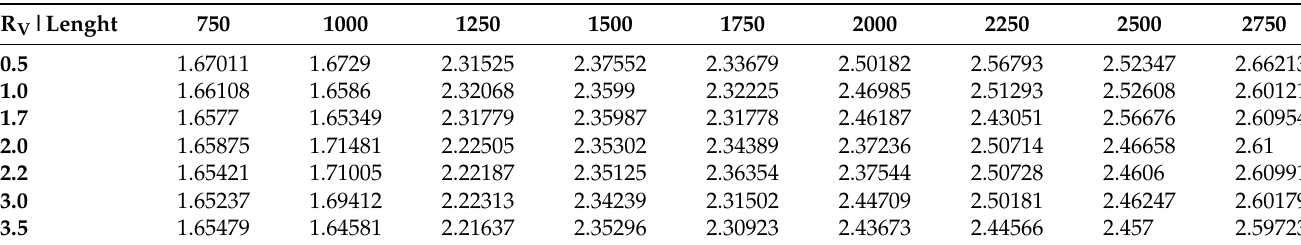
Table A14. Execution times in milliseconds on GPU with cable structure for 40,000 time-steps (2.0 s); R V on the Left and number of cells (length) on the Top .